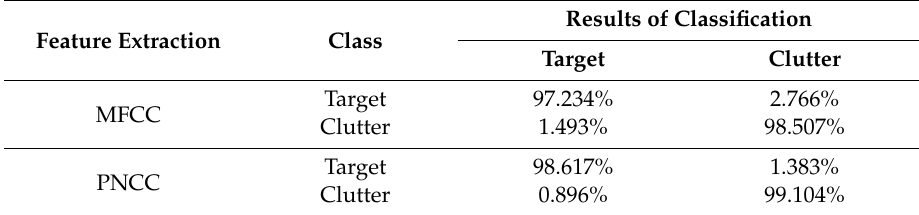
Table 3. Results of classification.